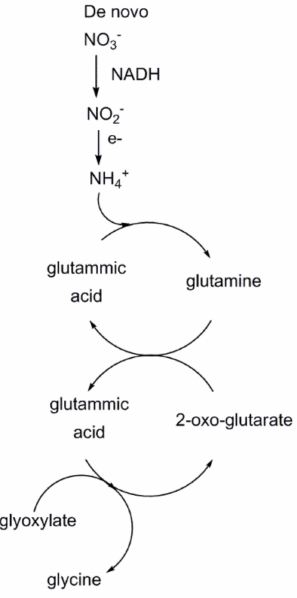
Figure 19. The newly proposed metabolic link between photorespiration and photosynthesis. The novo absorbed NO 3 − is reduced by NADH and electron transport to NH 4+ in leaves. In chloroplasts NH 4+ converts glutamic acid into glutamine that converts 2-oxo-glutarate to glutammic acid. Then glutamic acid is transported in peroxisomes where reaction with glyoxylate produces 2-oxo-glutarate and glycine. Considering that glyoxylate derives from 2-phosphoglycolate (2PG) which is de- phosphorylated to glycolate and oxidized to glyoxylate in peroxisomes, overall, the novo absorbed NO 3 − and glyoxylate are ultimately converted into glycine. (Previously unpublished